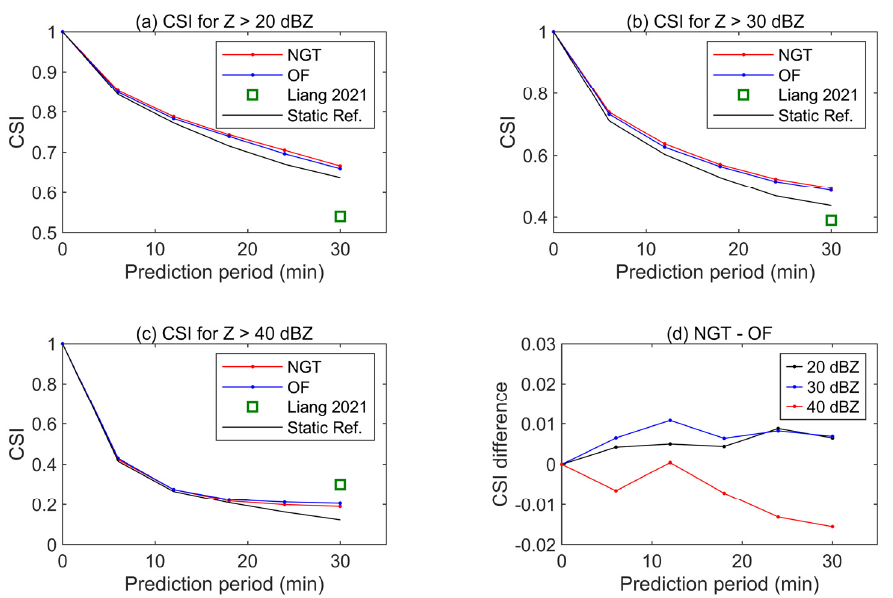
Figure 13. CSI of the prediction by NGT and OF for ( a ) Z > 20 dBZ, ( b ) Z > 30 dBZ, ( c ) Z > 40 dBZ, and ( d ) NGT—OF. The prediction starts at 11:00 UTC on 21 June 2017. Liang 2021 is cited from [18] as a deep learning method for comparison.